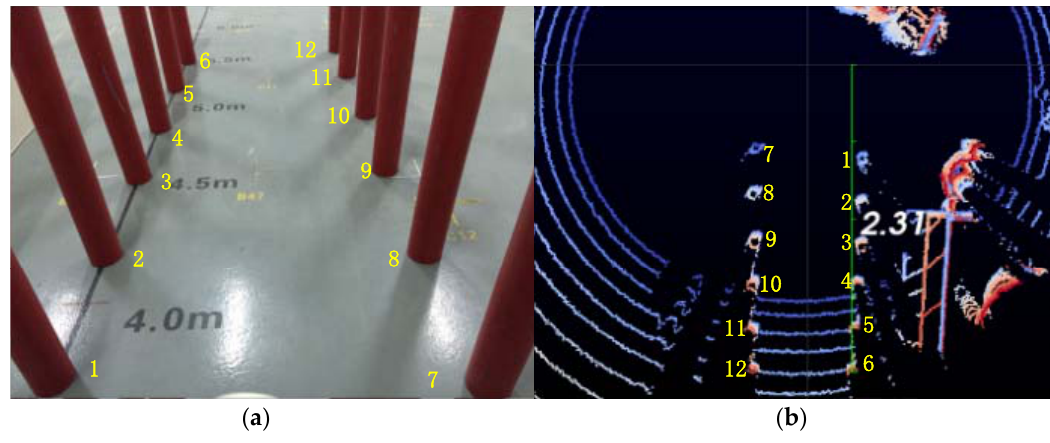
Figure 4. Transformation between data from the image and LIDAR. ( a ) Image points in camera coordinates; and ( b ) absolute coordinates in the world coordinate system.